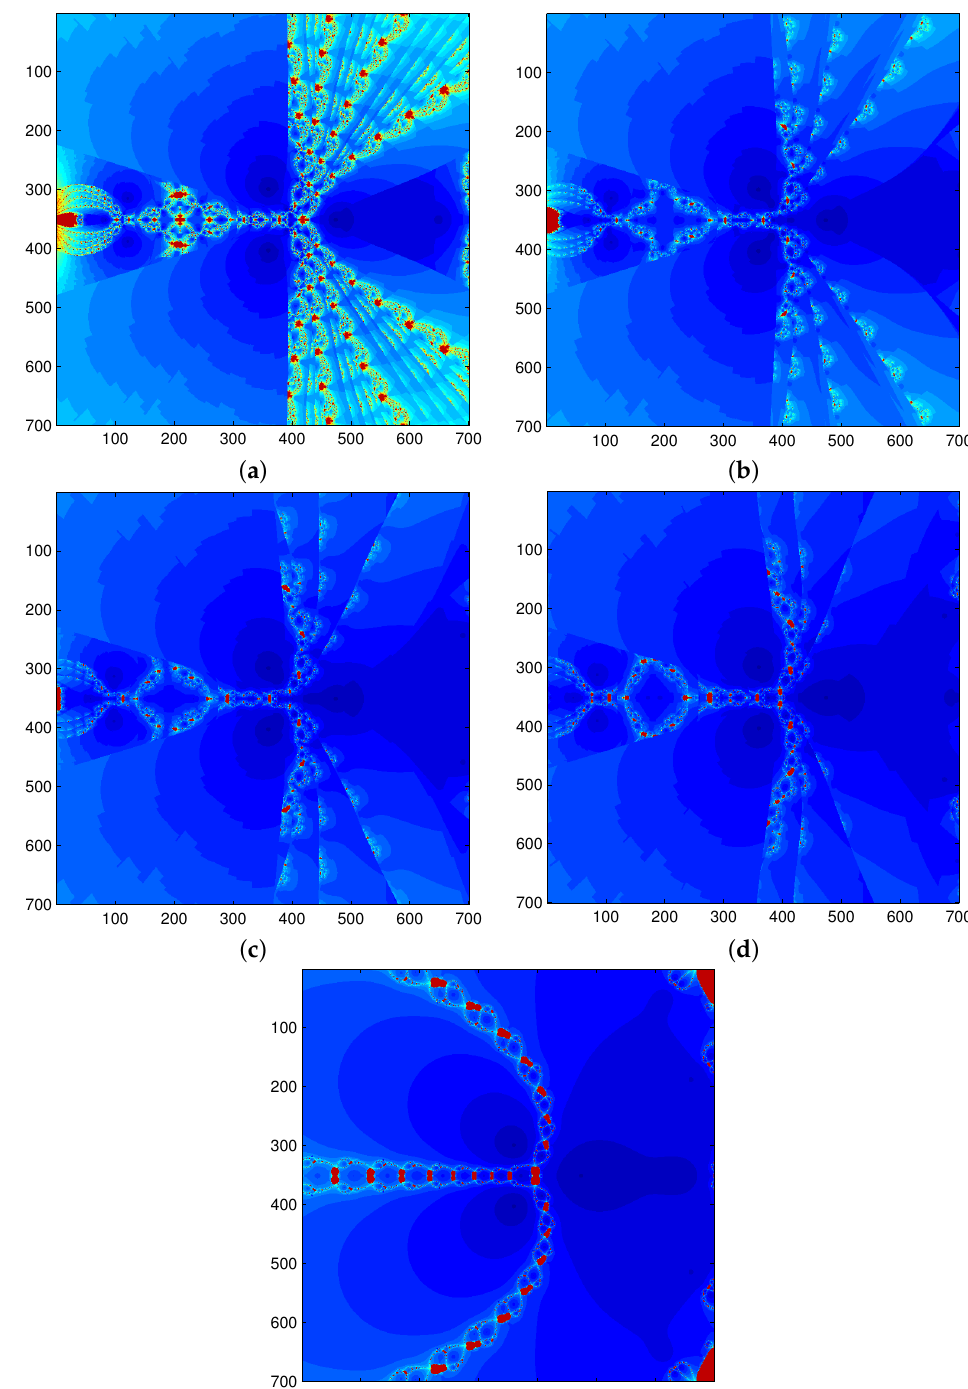
Figure 8. Dynamics of the proposed method with variable values of β for F 2 ( x ) = x 3 − 2 x 2 + x − 1: ( a ) proposed method at β = 0.1; ( b ) proposed method at β = 0.3; ( c ) proposed method at β = 0.5; ( d ) proposed method at β = 0.7; ( e ) proposed method at β =